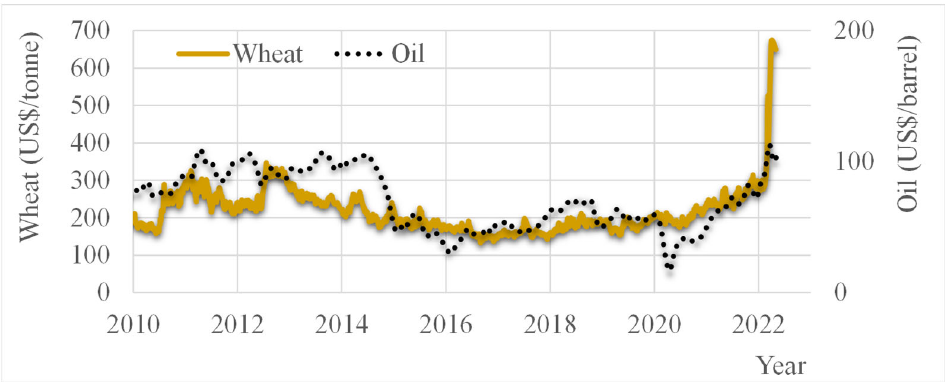
Figure 4. Prices of wheat (data from [82]) and oil (data from [83]) (January 2010, June 2022).